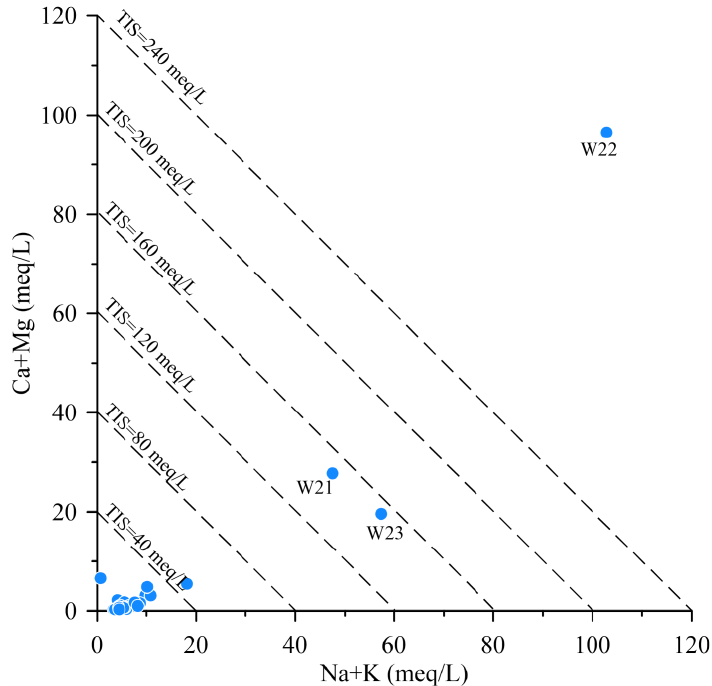
Figure 3. Correlation plot of Na+K vs. Ca+Mg for the sample thermal springs in the research area, also showing the iso-ionic-salinity (TIS) lines for reference.